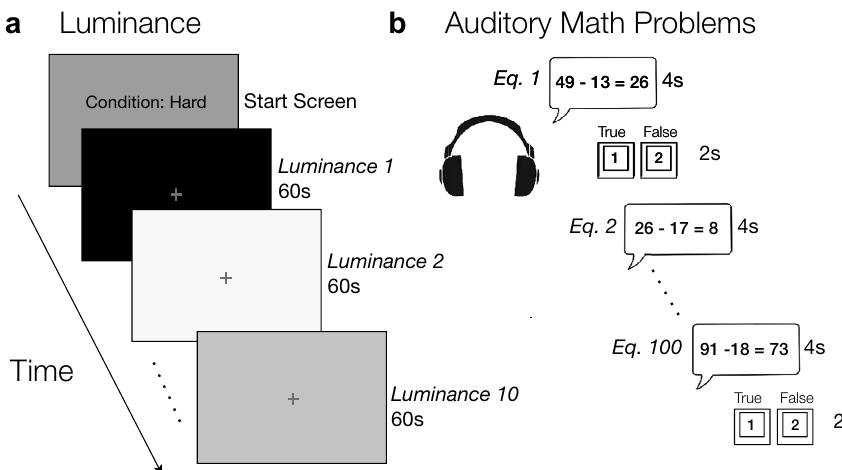
Figure 2. Experimental design. ( a ) Example luminance sequence for a Hard block. Participants viewed 10 different luminances presented pseudorandomly for 60 s each. ( b ) While viewing the luminances, participants simultaneously listened to and carried out solving back-to-back auditory math problems, indicating on a keyboard whether the problem given was true or false. Accuracy on the math problems were given at the end of the